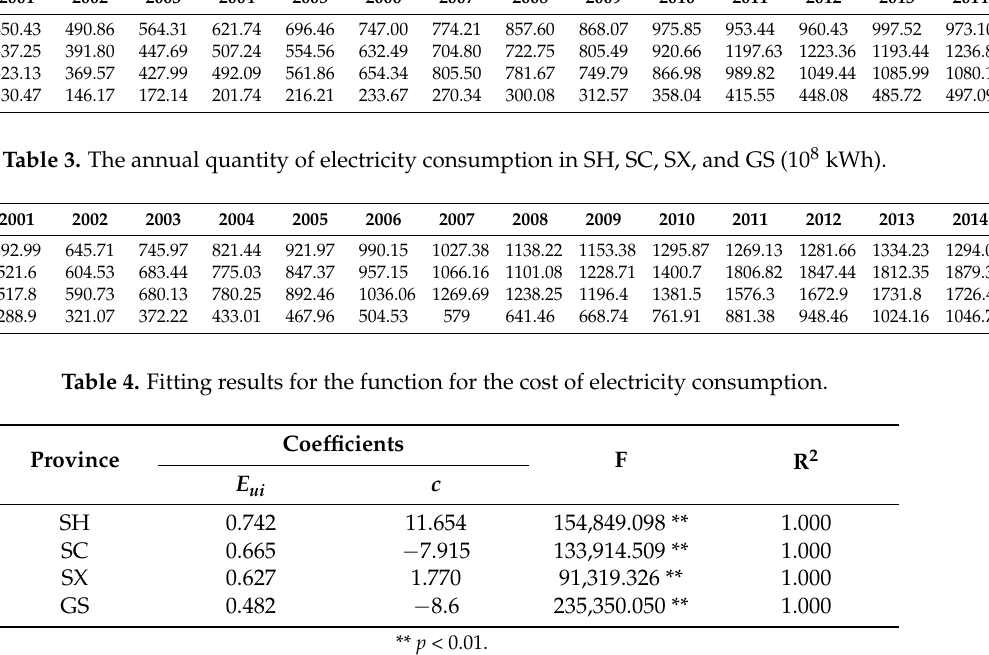
Table 2. The annual net cost of electricity consumption in SH, SC, SX, and GS (10 8 CNY). Province 2001